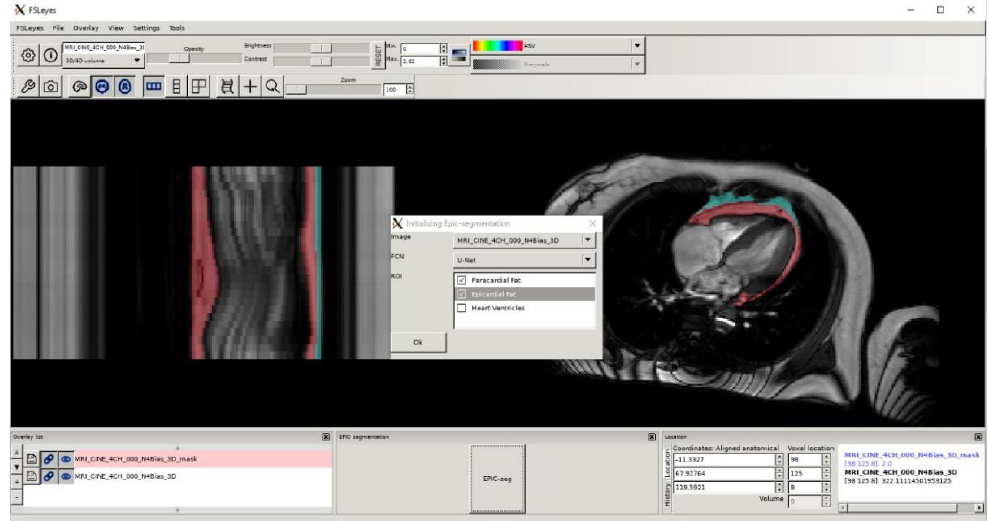
Figure A2. FSLeyes plugin interface for epicardial and paracardial segmentation will facilitate reproducibility of proposed methods.